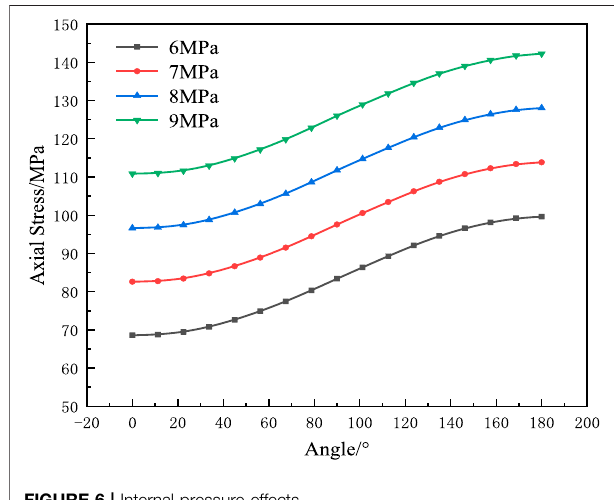
FIGURE 6 | Internal pressure